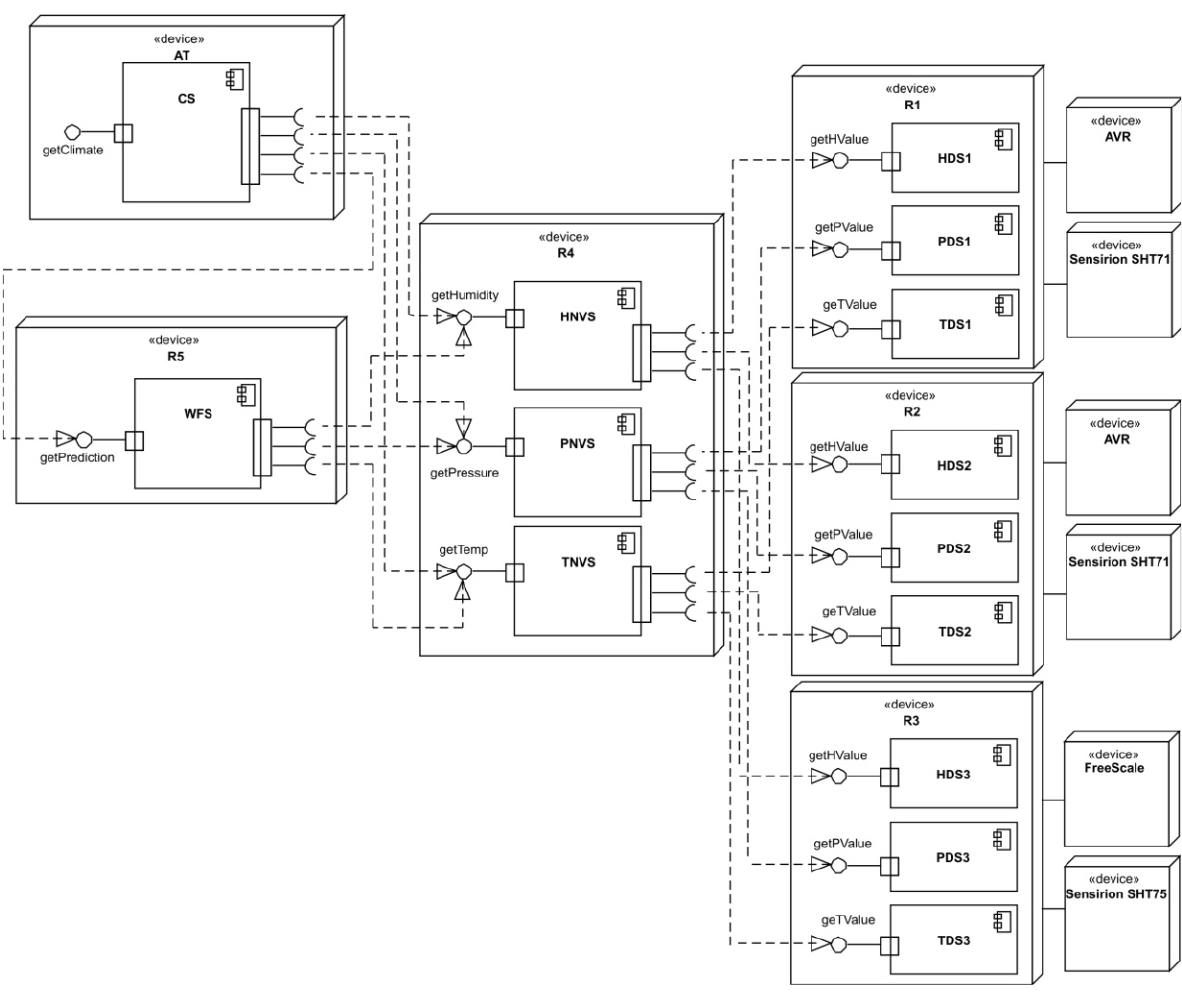
Figure 5. Deployment diagram of the